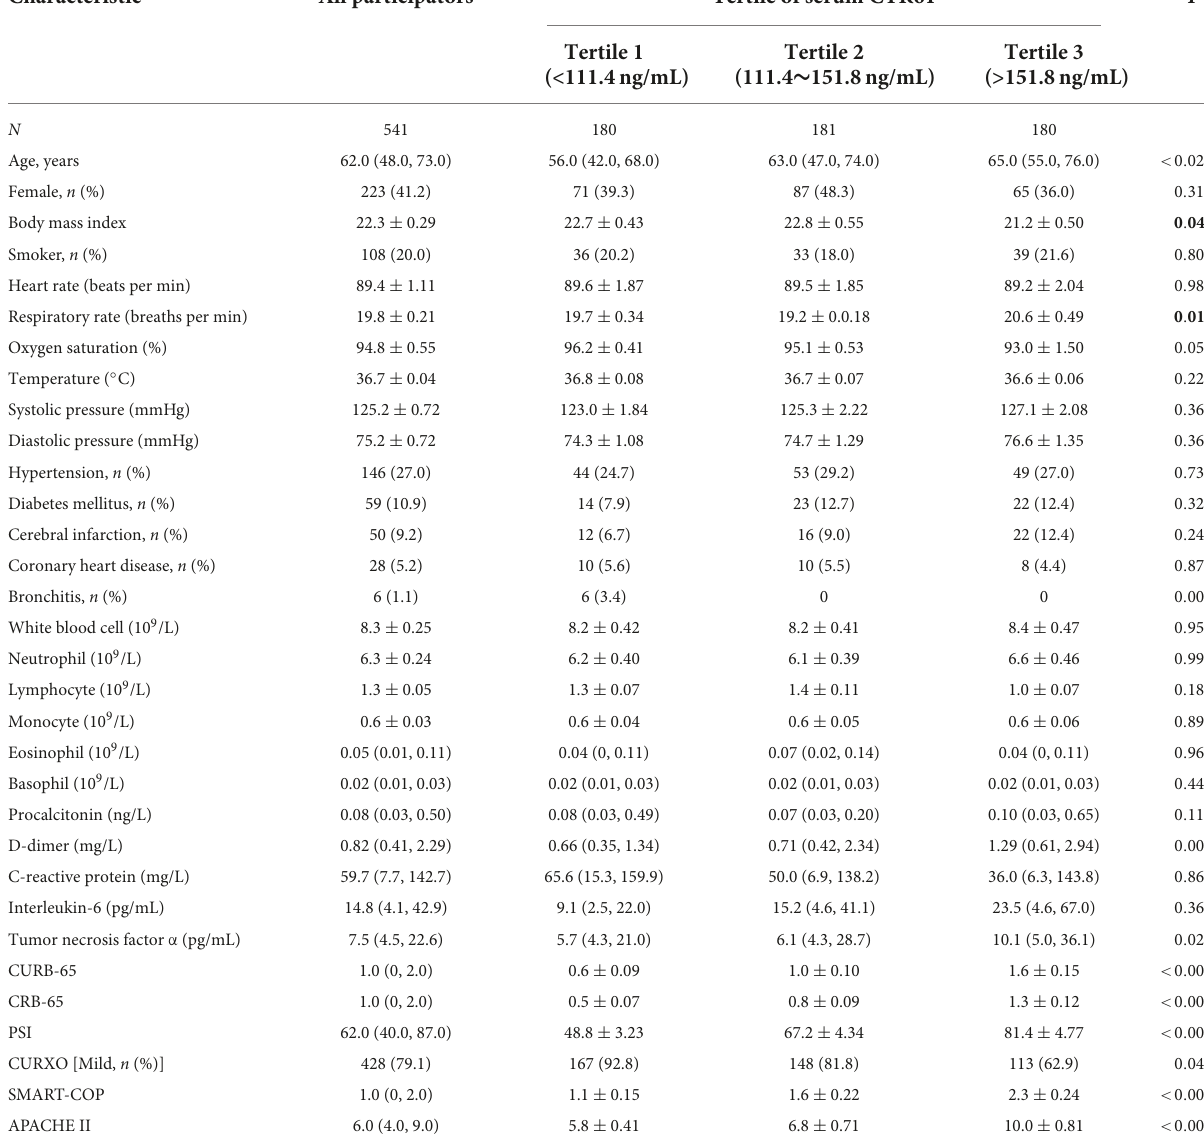
TABLE 1 Demographic characteristics of participators at